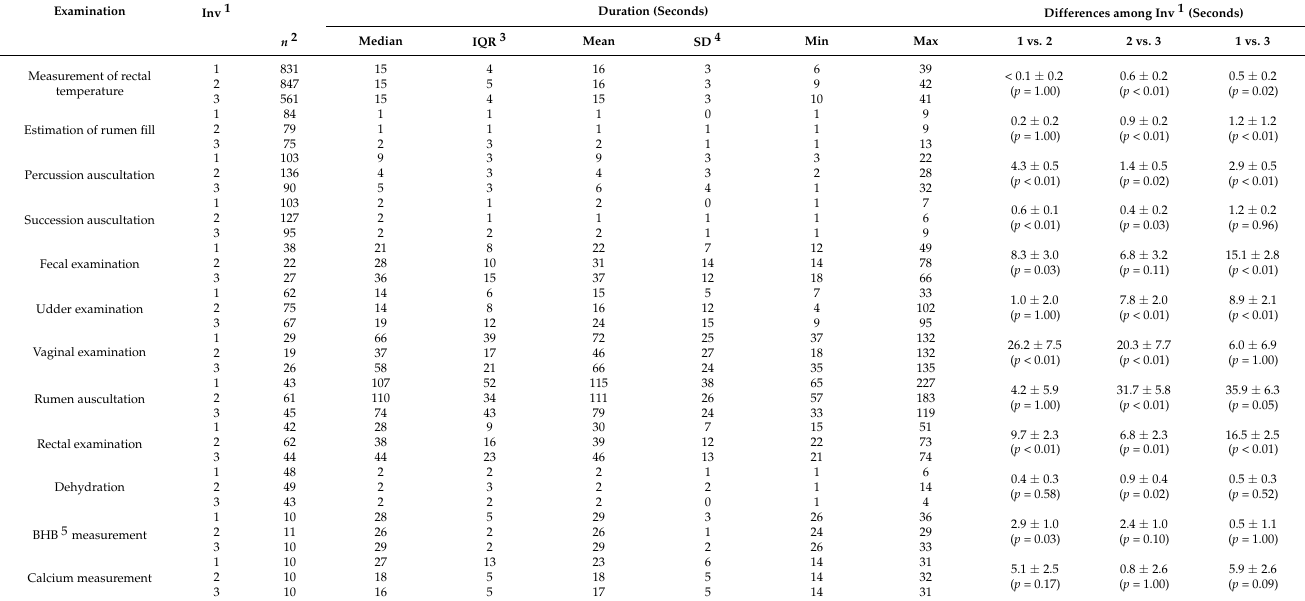
Table 5. The duration of examinations presented for each of the three investigators (Inv) and differences among the investigators (mean ± SD).